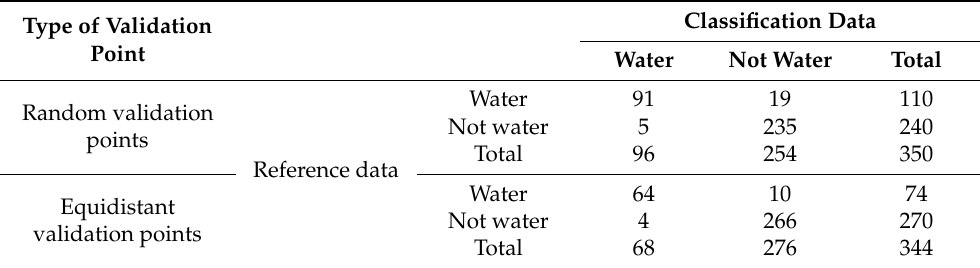
Figure 14. The distribution of validation points in Wuhan. ( a , b ) are the distributions of random validation points and equidistant validation points, respectively. Table 9. Confusion matrix for mapping.